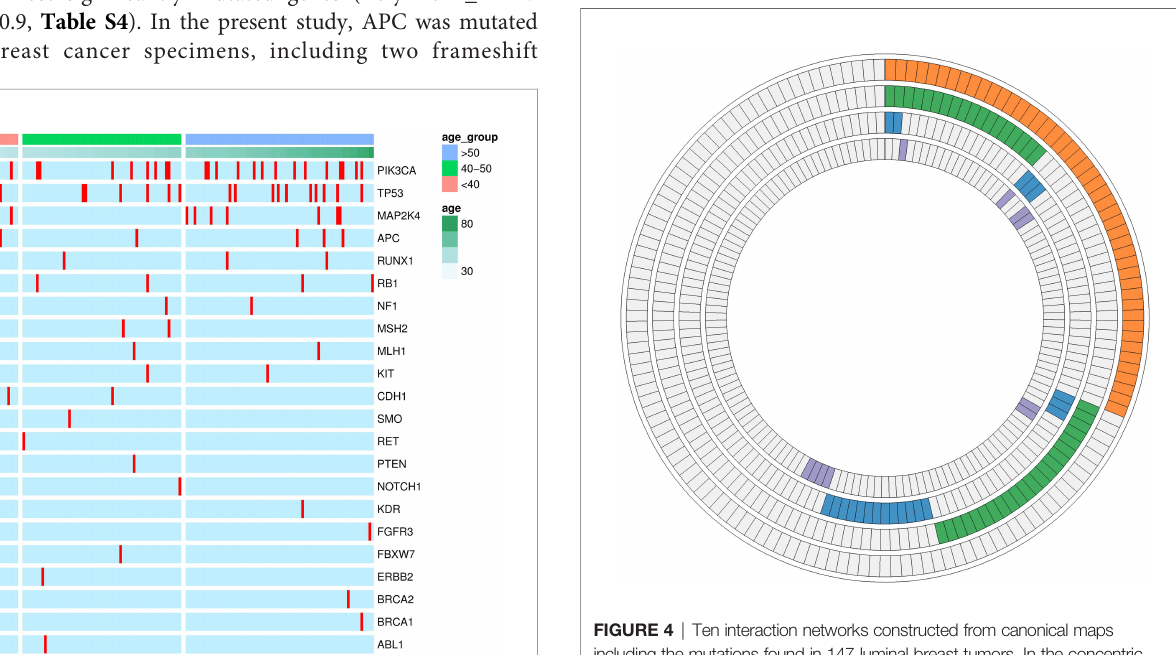
the score difference between variants. Based on the scores of PolyPhen, NOTCH1, ABL1, SMO, APC, KDR, FGFR3, MLH1, PIK3CA, MSH2, RUNX1, TP53, BRCA1, NF1 and CDH1 were the 14 most signi fi cantly mutated genes (PolyPhen2_HDIV score> 0.9, Table S4 ). In the present study, APC was mutated